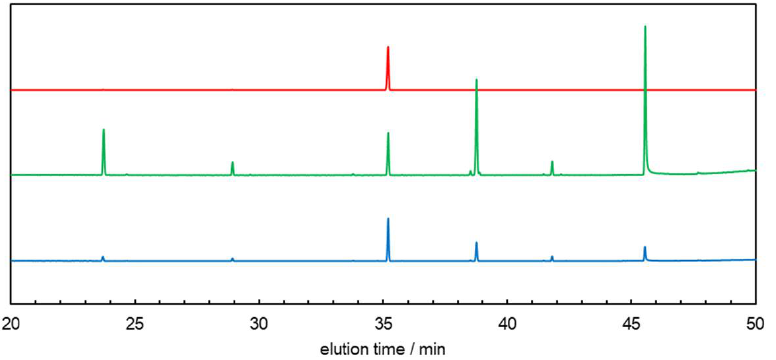
Figure 5. Gas chromatograms of gas components at reactor outlet by activated carbon tube solvent extraction method on each reaction (red: photocatalyst + UV irradiation, green: ozone + UV irradiation, blue: photocatalyst + ozone + UV irradiation).